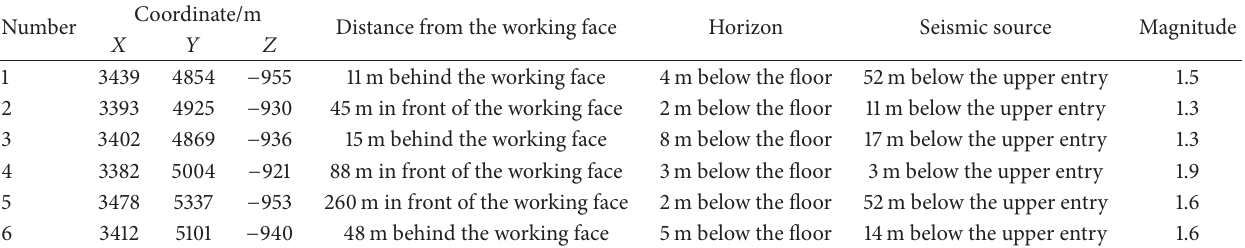
Table 1: The location statistics of mine tremor by using microseismic